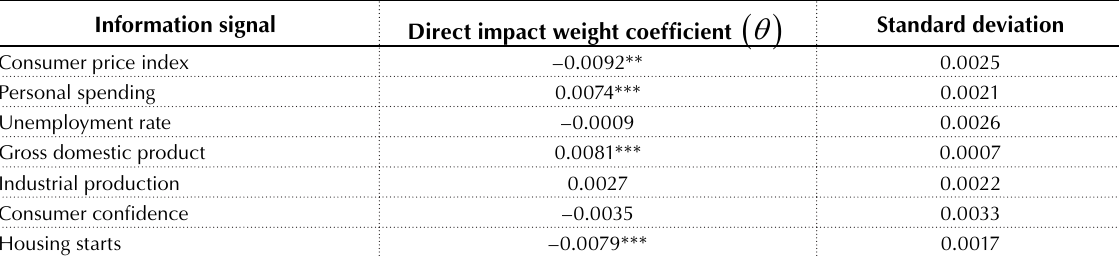
Table 5. The influence of the component of “surprise” on non-monetary information signals of the USA on the volatility of stock prices of enterprises of Ukraine in the economic sector “Oil & Gas” Source: Compiled and calculated by the authors.